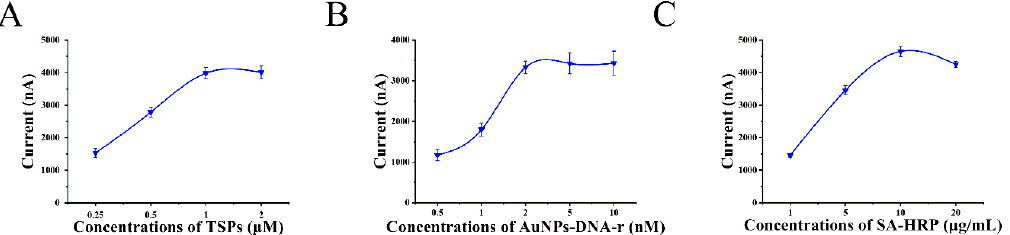
Figure 4. The optimization of the concentration of ( A ) TSPs, ( B ) AuNPs-DNA-r, ( C ) streptavidin (SA-HRP). Error bars show the standard deviations ( n = 4).